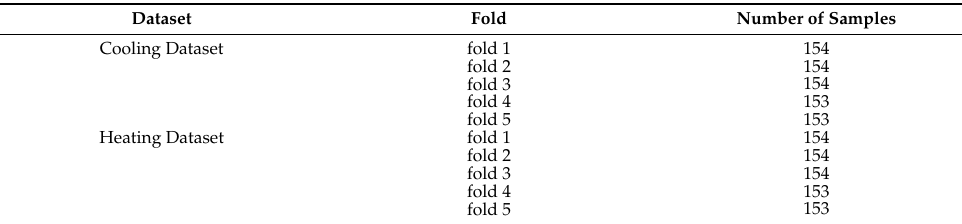
Table 9. Cooling Dataset and Heating Dataset Folds Summary. Dataset